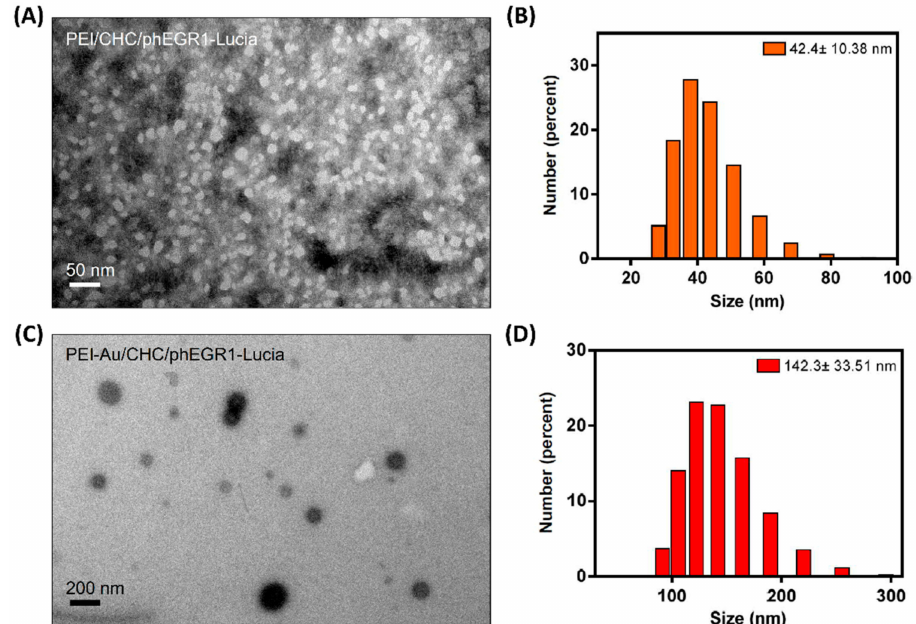
Figure3. MorphologycharacterizationofthePEI / CHC / phEGR1-Lucia(Polyethylenimine / carboxymethyl hexanoyl chitosan / phEGR1-Lucia) complex and PEI-Au / CHC / phEGR1-Lucia (Au cluster-incorporated polyethylenimine / carboxymethyl hexanoyl chitosan / phEGR1-Lucia) complex. ( A ) Transmission electron microscopy (TEM) image and ( B ) Dynamic light scattering (DLS) size distribution analysis of the PEI / CHC / phEGR1-Lucia complex. ( C ) TEM image and ( D ) DLS size distribution analysis of the PEI-Au / CHC / phEGR1-Lucia